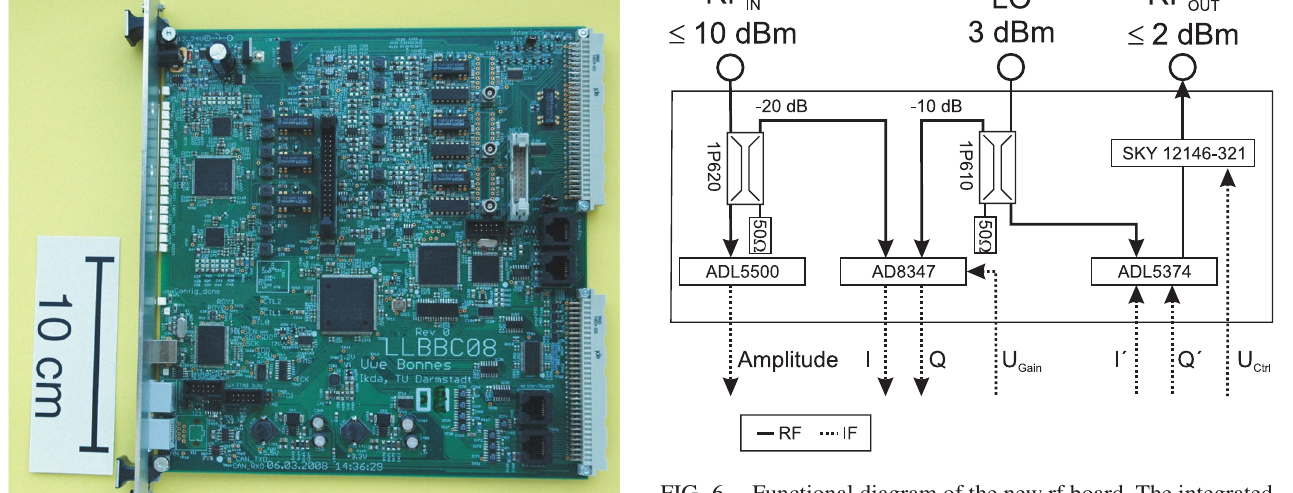
FIG. 6. Functional diagram of the new rf board. The integrated circuits are described in the text.